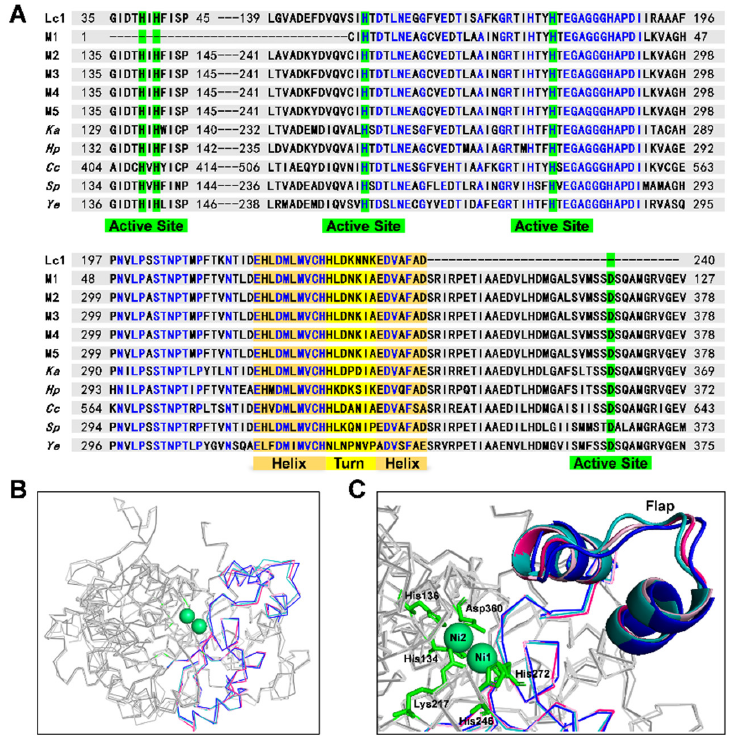
Figure 4. Alignment of identified rumen microbial ureases and known ureases. ( A ) Sequence alignment of identified rumen microbial ureases and ureases from Klebsiella Aerogenes ( Ka , PDB code: 4EP8), Helicobacter pylori ( Hp , PDB code: 1E9Y), Cajanus cajan ( Cc , PDB code: 4G7E), Sporosarcina pasteur (S p , PDB code: 4CEX), and Yersinia enterocolitica ( Ye , PDB code: 4Z42). Number represents the location of residue in their urease sequences. Residues identical in these all ureases are in blue. The flap (helix-turn-helix) regions are highlighted in orange (helix) and yellow (turn). The residues of active sites are highlighted in green. ( B ) Stereodiagram of identified rumen microbial ureases of Lc1 and M3 and ureases from Klebsiella Aerogenes and Helicobacter pylori . Their flap and flanking regions are colored in pink, rose red, cyan, and blue, respectively. Nickel ions are indicated as green balls. ( C ) Stereodiagram of active sites (in green) and flap regions from identified rumen microbial ureases of Lc1 (in pink) and M3 (in rose red) and ureases from Klebsiella Aerogenes (in cyan) and Helicobacter pylori (in